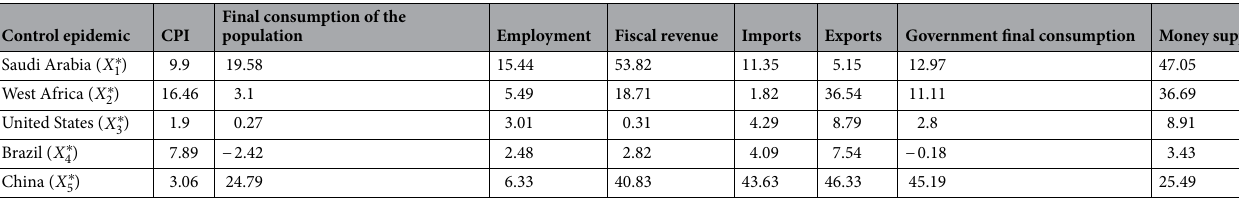
Table 1. Indicators of economic recovery performance factors in the six-month period after the control epidemic. Source: WIEGO statistical database and BvD-EIU CountryData